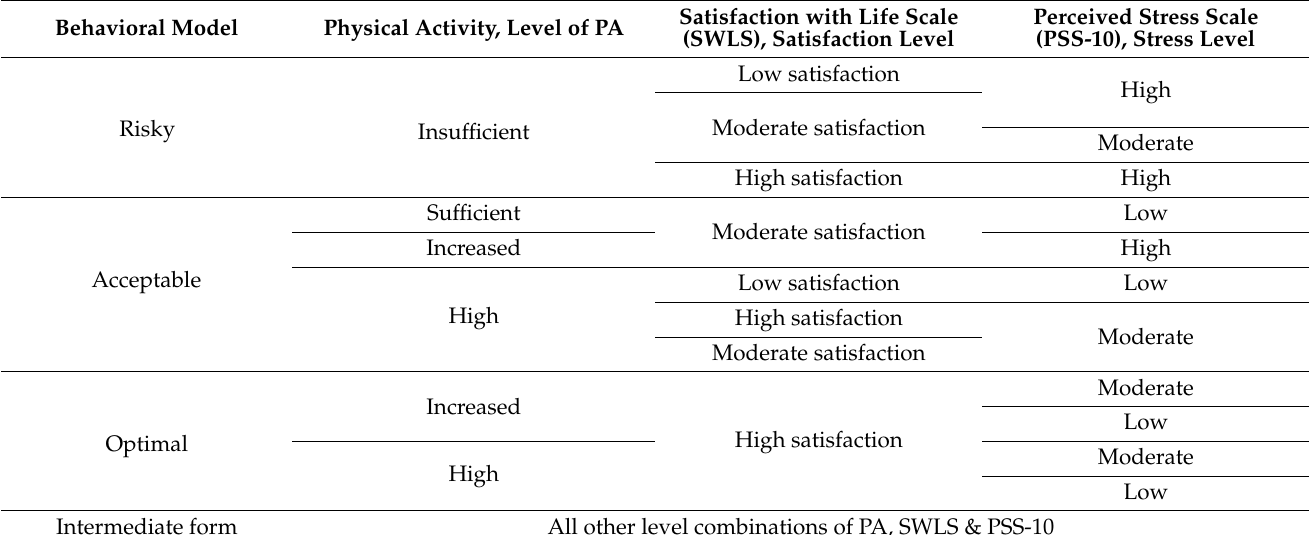
Table 8. The classification of behavior models aimed at coping with stress.